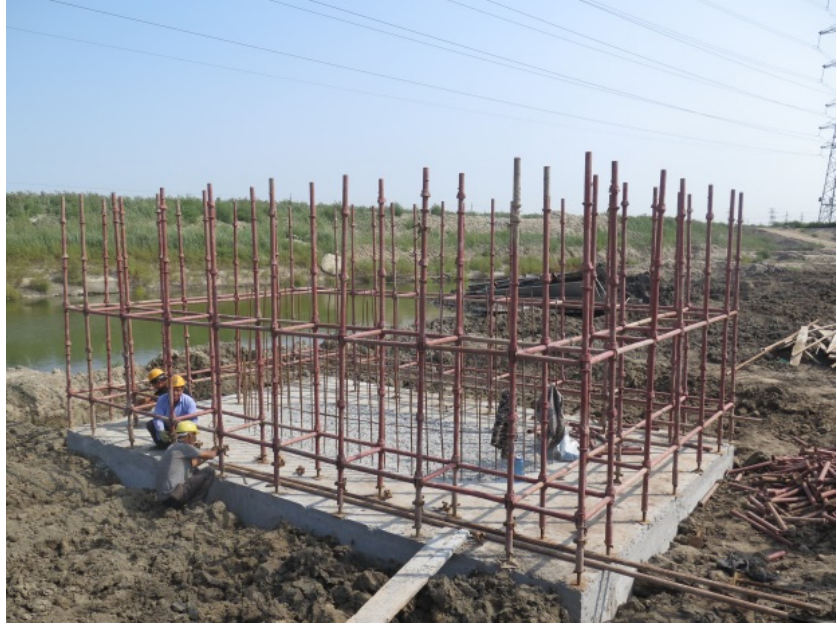
Figure 6. Testing site.